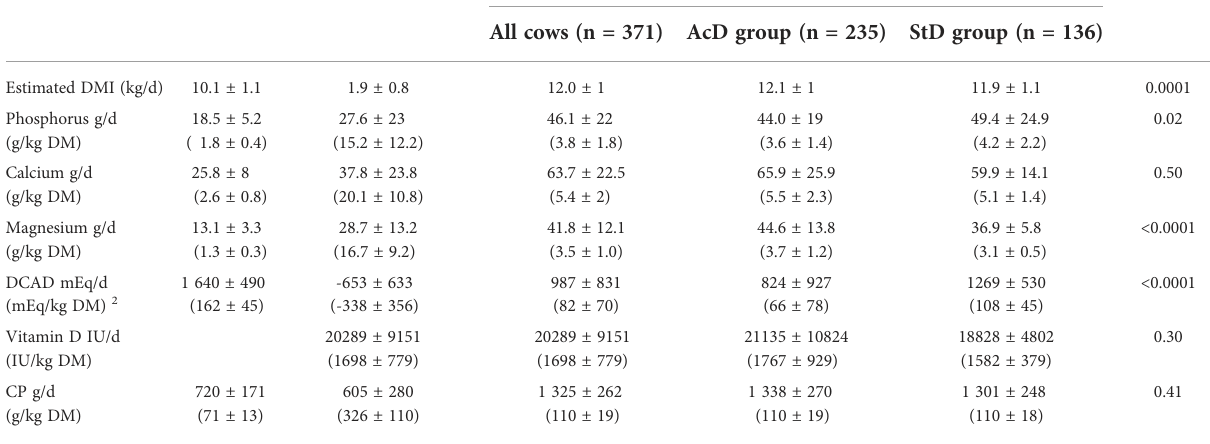
TABLE 2 Estimates of dry matter intake (DMI), mineral elements, vitamin D, and crude protein (CP) intake from forage, commercial mixes, and diet treatment for the 371 cows included in the cohort study. Element